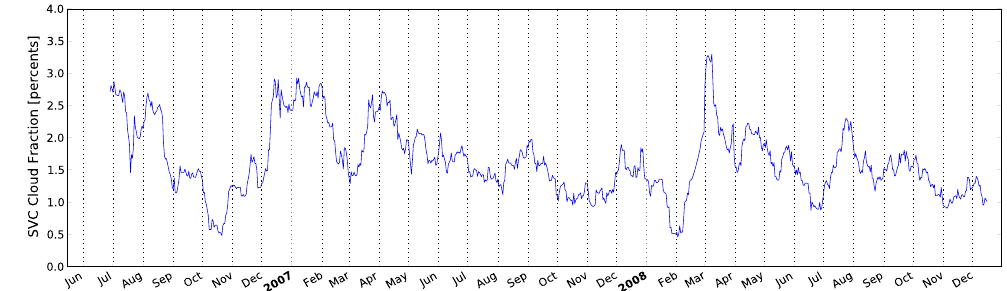
Fig. 13. Average cloud fraction of SVC (defined as in Fig. 12) in the Tropical band in the Monsoon-affected area (see text), averaged using a 31-days moving window to account for the increase in noise due to the smaller sample size compared to Fig. 12. Fig.%14